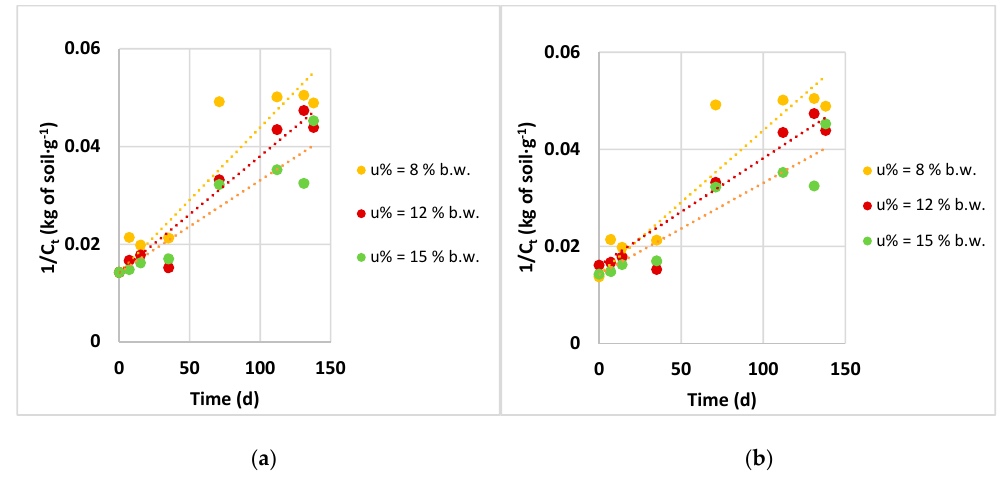
Figure 10. Second-order model for microcosms with C/N = 120: ( a ) C 0 = 70 g · kg − 1 of soil; ( b ) C 0 was measured.